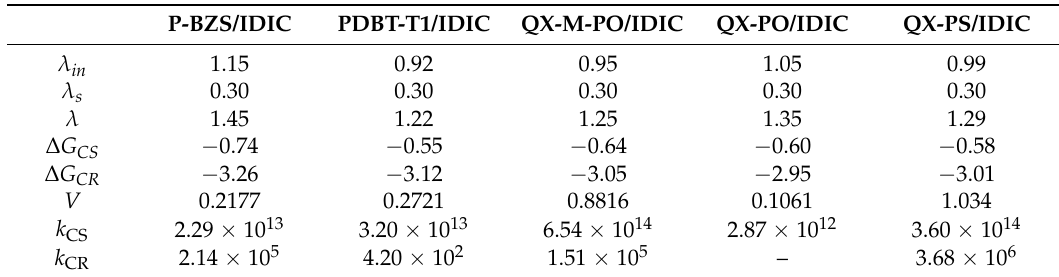
Table 13. Dynamic parameters of the polymers/IDIC interfaces: inner reorganization energy λ in (eV), outer reorganization energy λ s (eV), free enthalpy of the reaction ∆ G (eV), the rates of exciton-separation k CS (s − 1 ), and charge-recombination k CR (s − 1